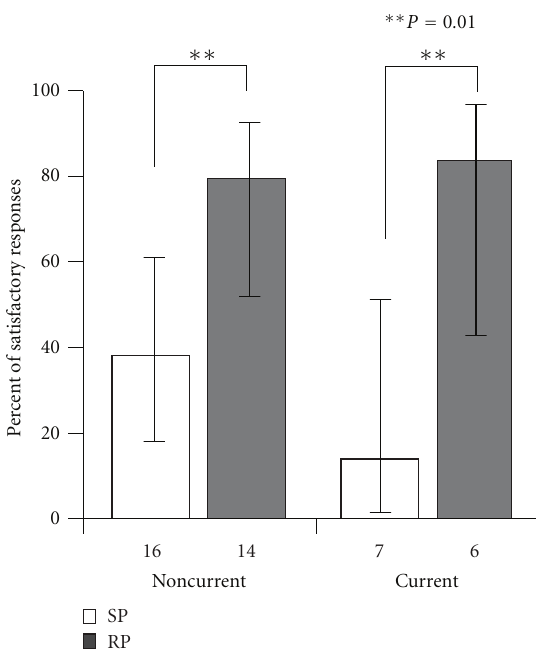
Figure 5: Percent of satisfactory responses to unexpected hazardous events on the blind side in the sham prism (SP) and real prism (RP) drives for the eight participants with blindside events in both drives. The diagonal line represents identical performance in the two drives. Six drivers (three current and three noncurrent) had a higher proportion of satisfactory responses in the RP than the SP drive (data points above the diagonal; P = 0 . 03). Table 3: Percent (median and range) of satisfactory scores for ratings of skills during specific maneuvers.